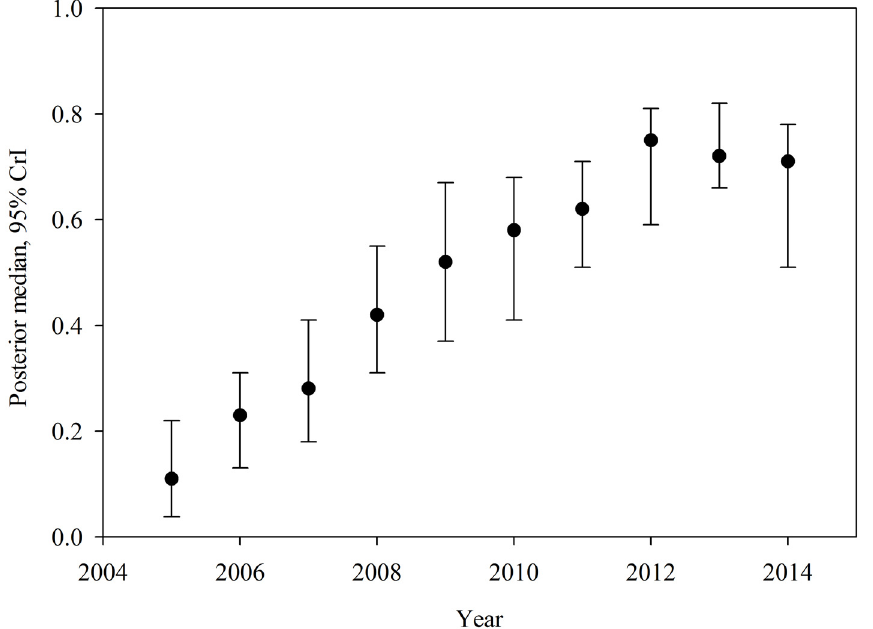
Fig 2. The posterior median and 95% CrI for the overall time trend in the covariate